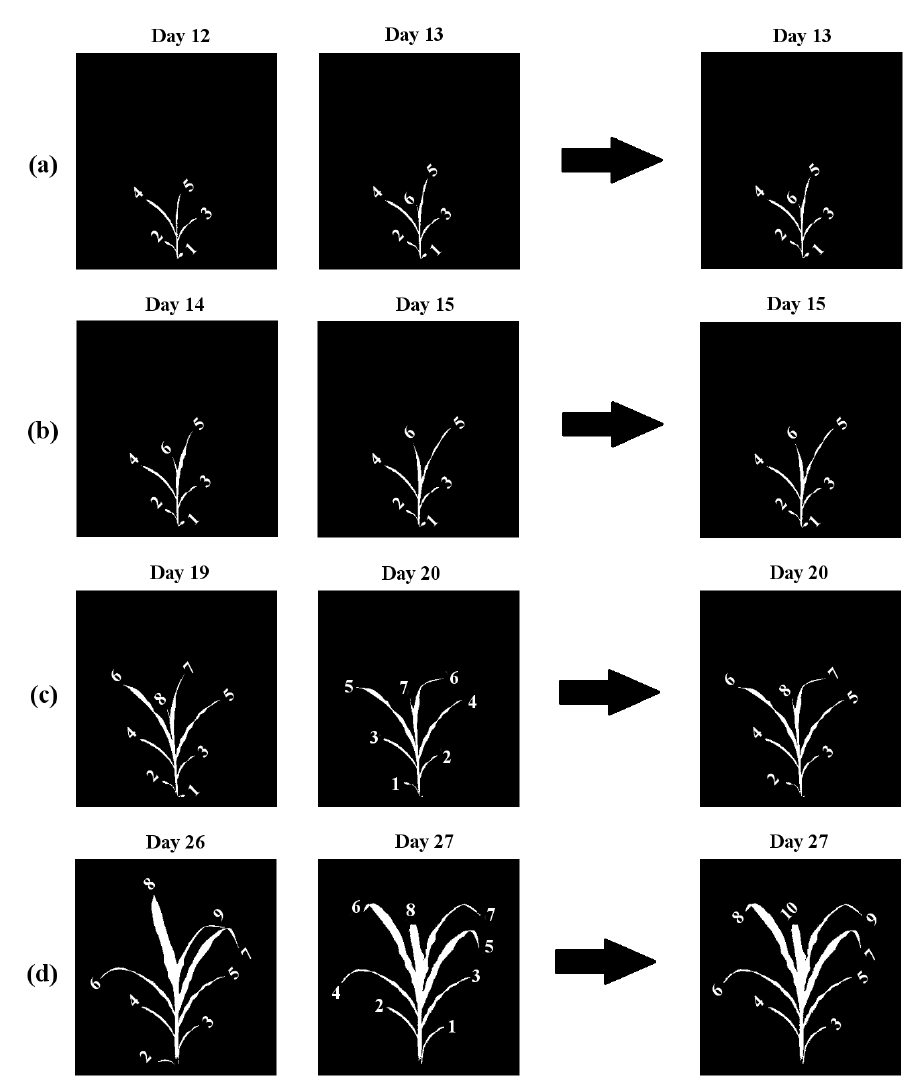
Figure 5. Four scenarios for leaf emergence ordering for tracking: ( a ) Case 1, leaf emergence; ( b ) Case 2, no change; ( c ) Case 3, leaf loss; and ( d ) Case 4, loss and emergence. Algorithm 3 summarizes the leaf tracking process for the plant image sequence using graphs generated by Algorithm 1. The leaf tracking algorithm begins with a sequence of labeled graphs { G 1 , G 2 , . . . , G n }, where G i is the graph for day i for a plant and n is the number of days the plant is imaged. The leaves for each plant in the graph are labeled starting with 1, as each plant was labeled independently. The problem of tracking reduces to finding the correspondence between the leaves of two consecutive plants, i.e., graphs G i and G i + 1 . We assume that G i has been properly labeled, and we must label G i + 1 . As